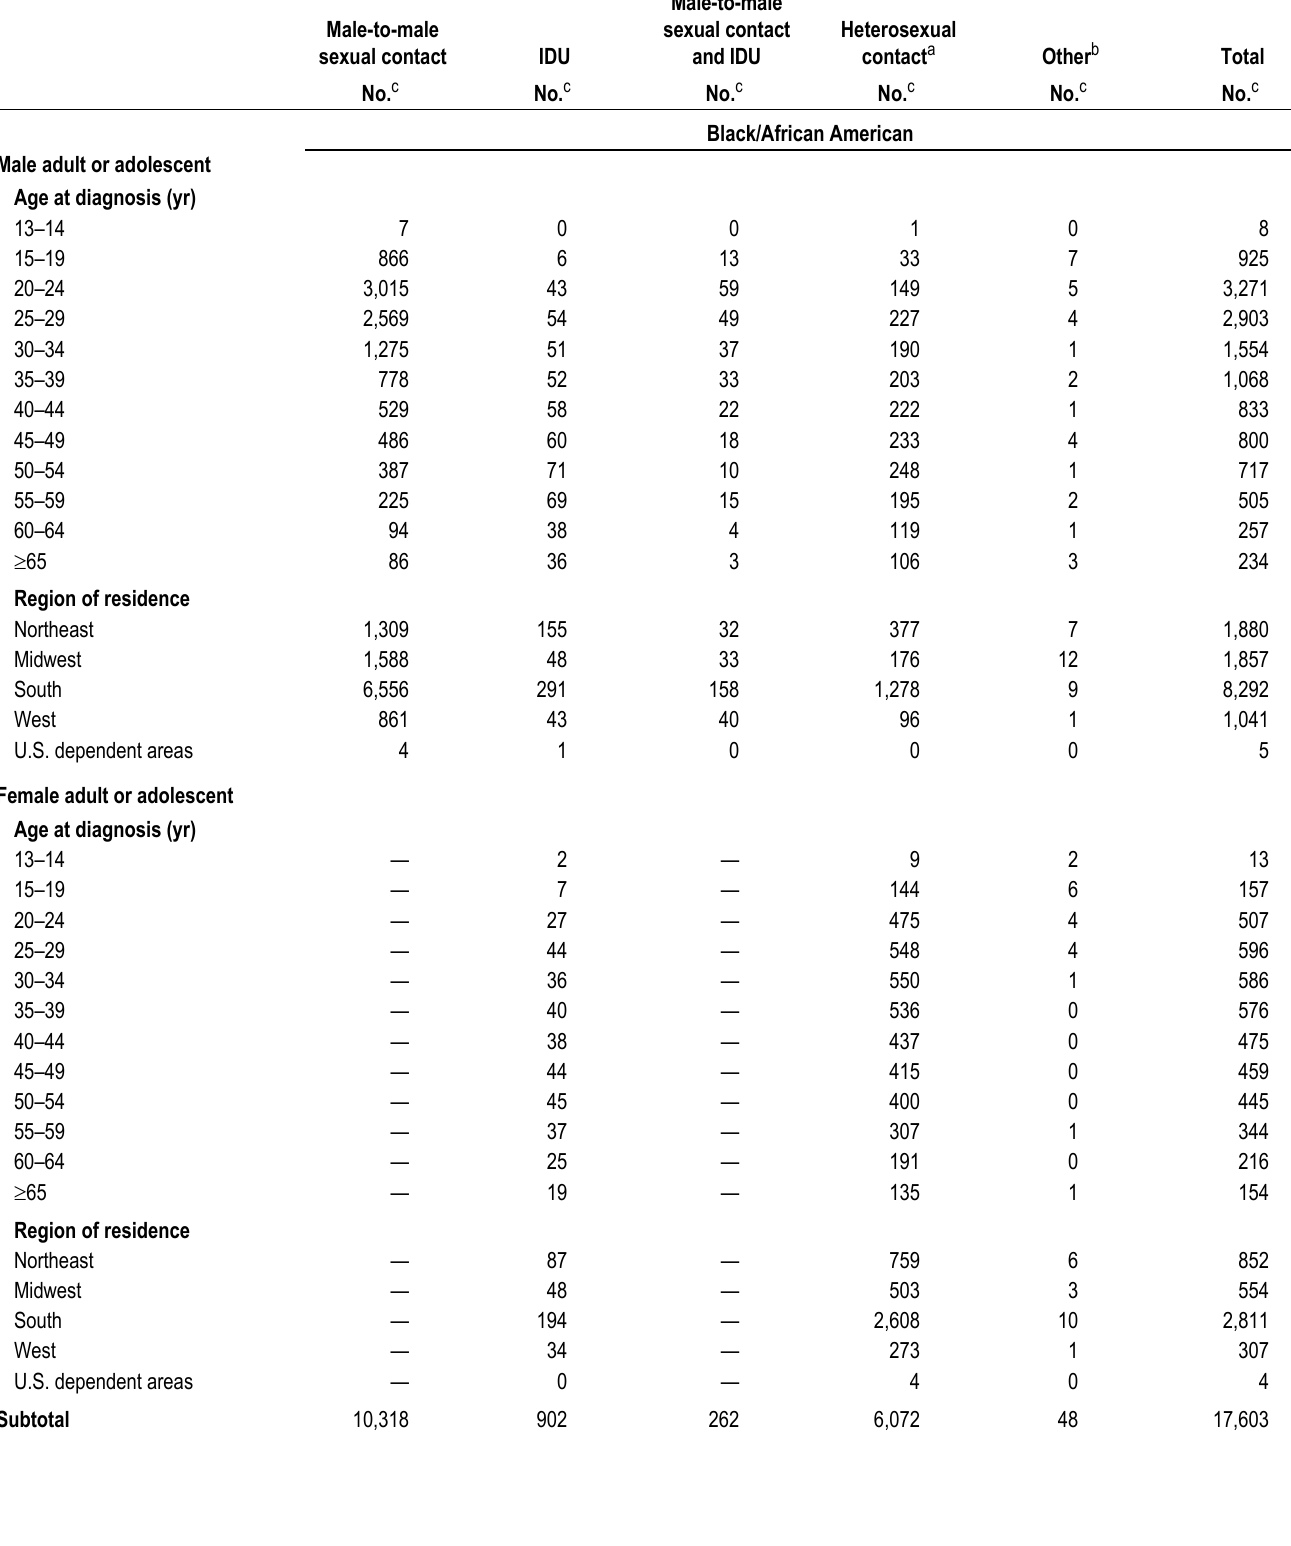
Table 5b. Diagnoses of HIV infection, by transmission category, race/ethnicity, and selected characteristics, 2015—United States and 6 dependent areas